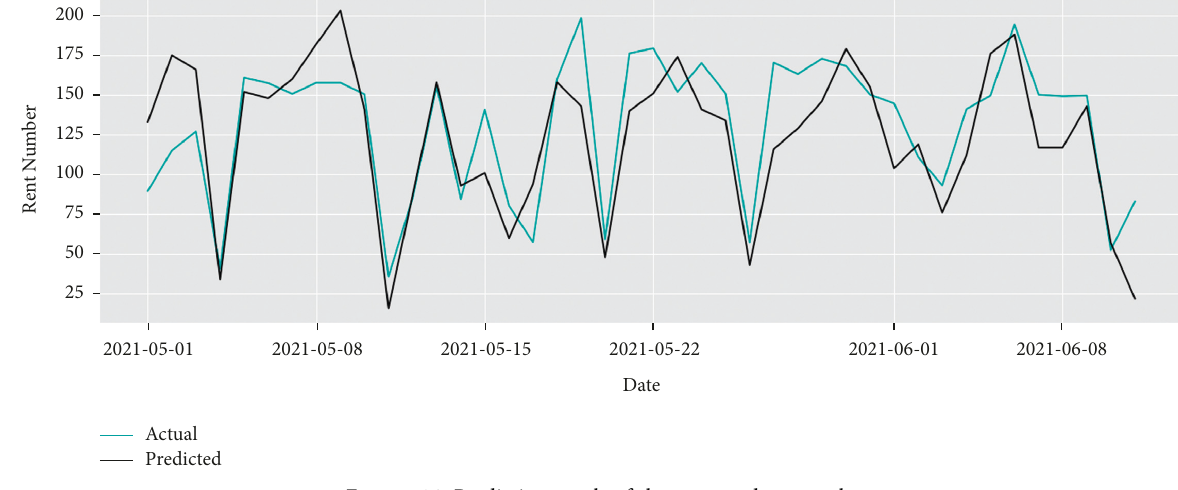
Figure 14: Prediction result of the proposed approach. Table 3: Comparison of the proposed approach with different individual models.